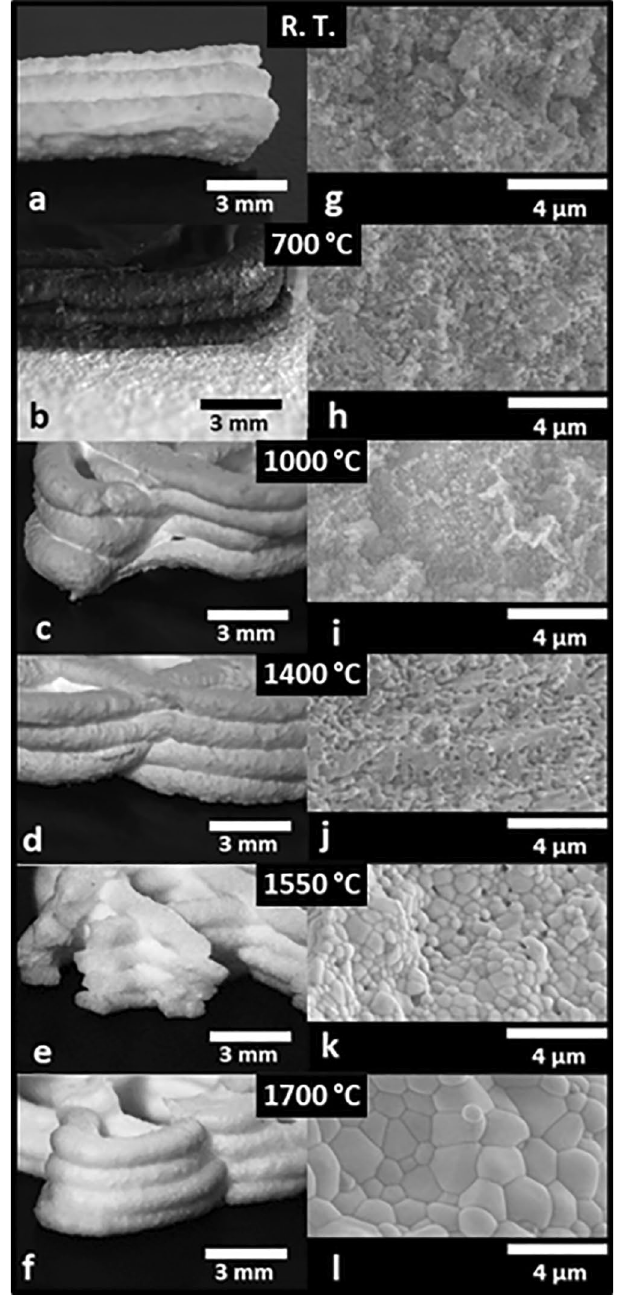
Figure 7. High-resolution images ( a - f ) and SEM micrographs ( g - l ) of fractured cords at different